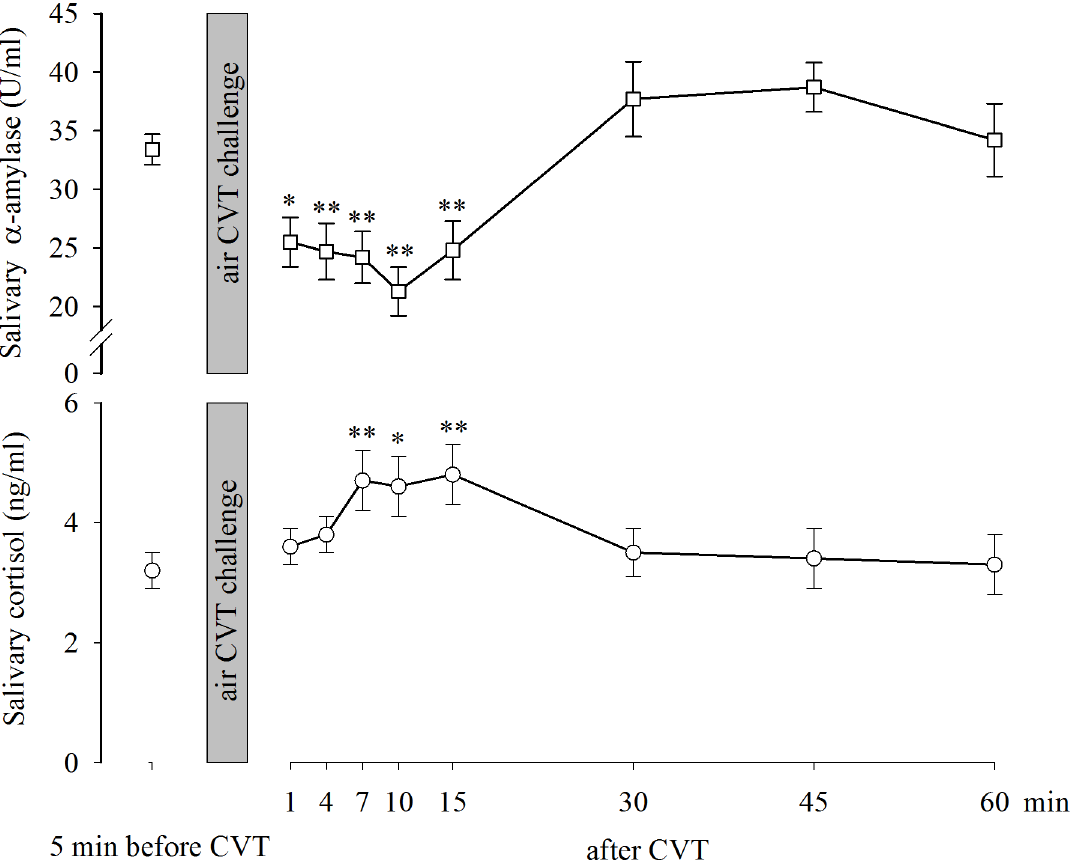
Fig 2. Diurnal trajectories of salivary α -amylase and cortisol before and after CVT stimulation. Data are expressed as the mean±SE. (cid:3) , (cid:3)(cid:3) : p < 0.01 and p < 0.001, respectively, vs before the CVT.